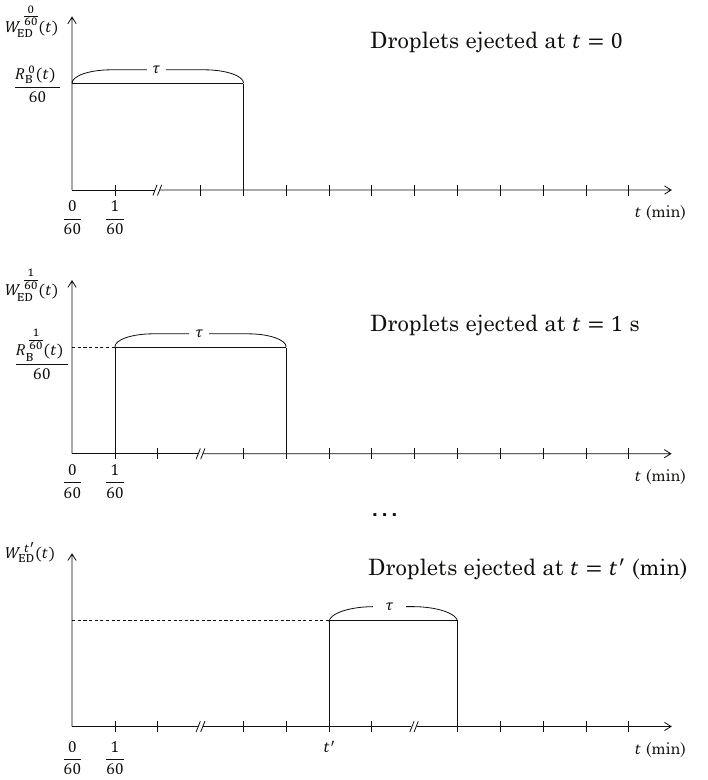
Figure 9. A schematic representation of the mass of the ejected droplets at each moment of the ejection ( t (cid:48) ) as functions of the blowing time t ( W t (cid:48) of the droplets at t (cid:48)